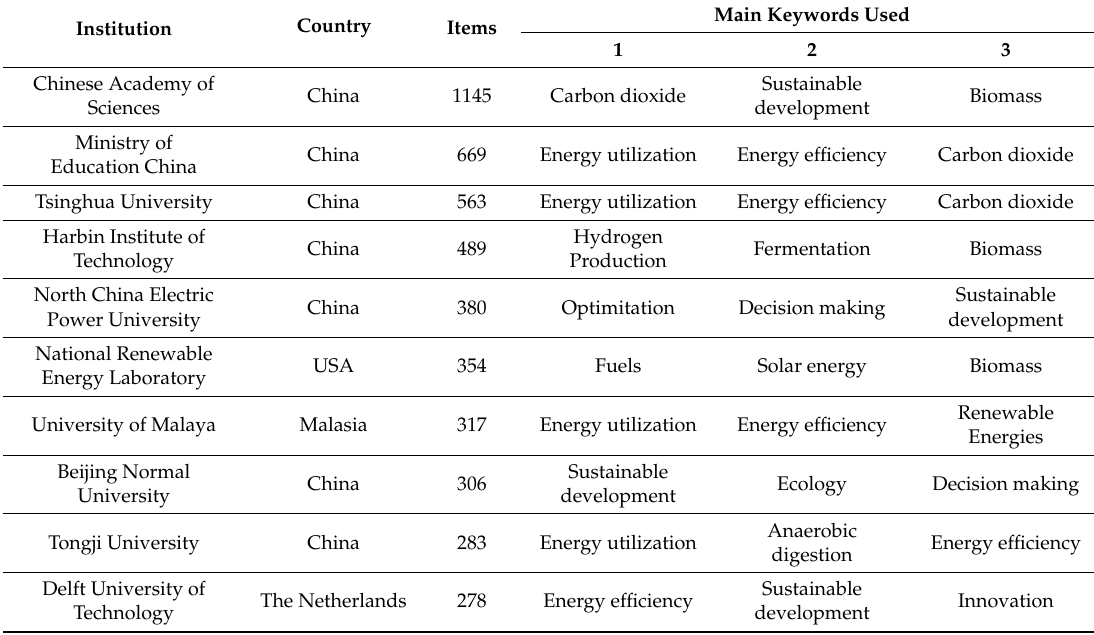
Table 1. Ranking of the top 10 most productive international